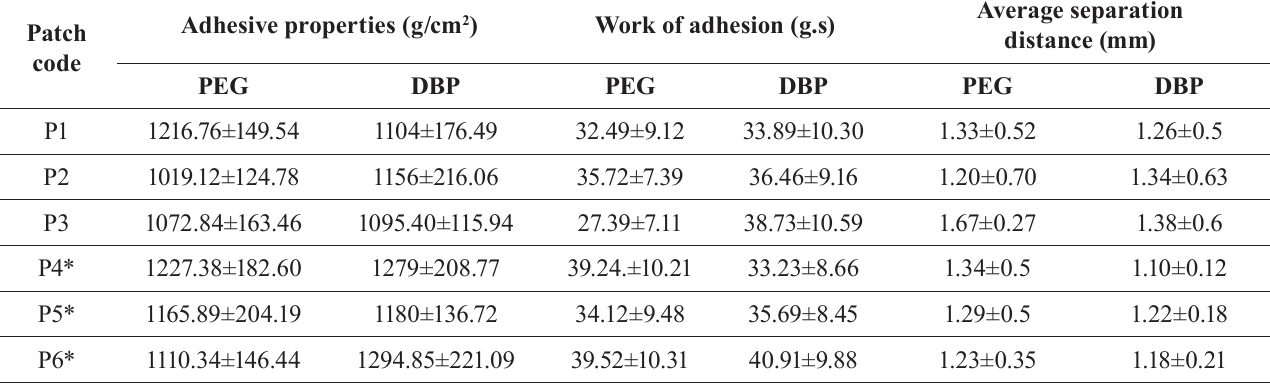
TABLE VII - Tack properties of different patches (n=3)